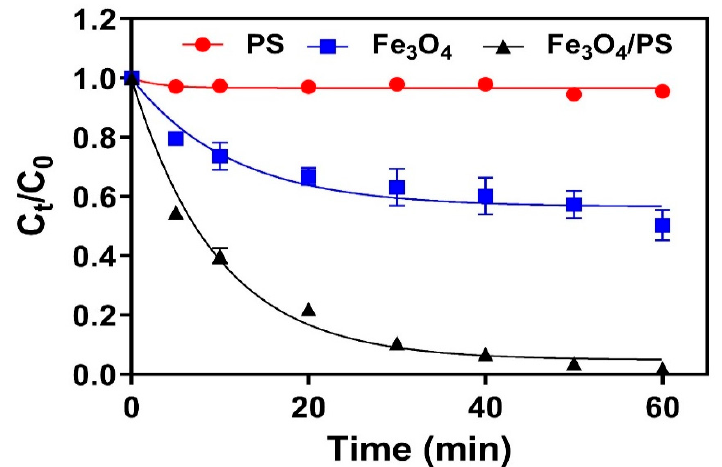
Figure 3. The normalised concentration of TC removed by PS, Fe 3 O 4 , and Fe 3 O 4 /PS over experimental time ([Fe 3 O 4 ] = 1.0 g/L, [PS] =1.0 mM, [TC] = 41.6 μ M, pH = 4.8).